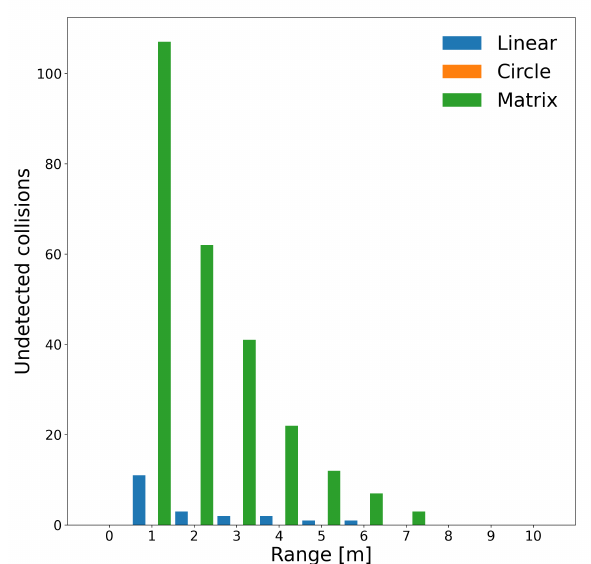
Figure 14. Undetected collisions according to interval size